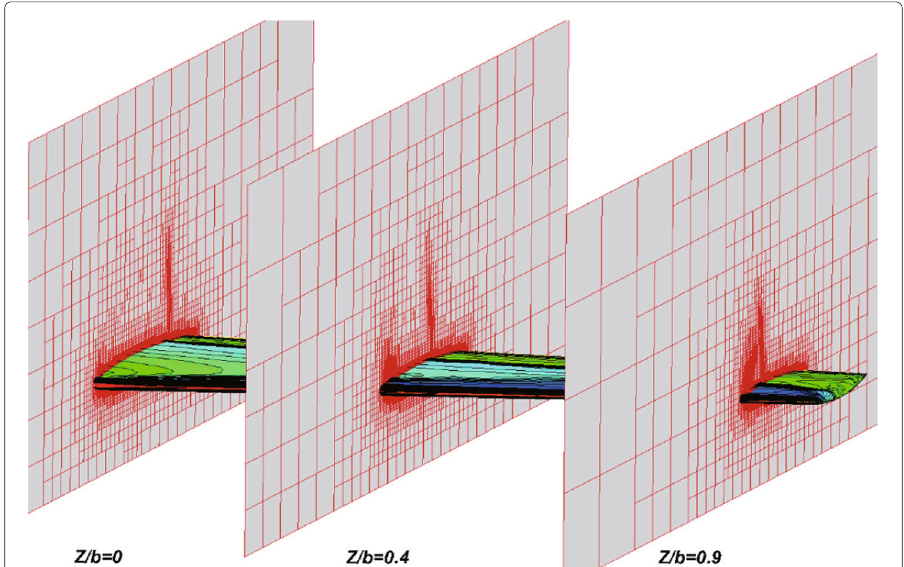
Fig. 22 Partial view of the adaptive grids with solution-based AMR ( Z / b = 0, Z / b = 0.4, Z / b = 0.9 )